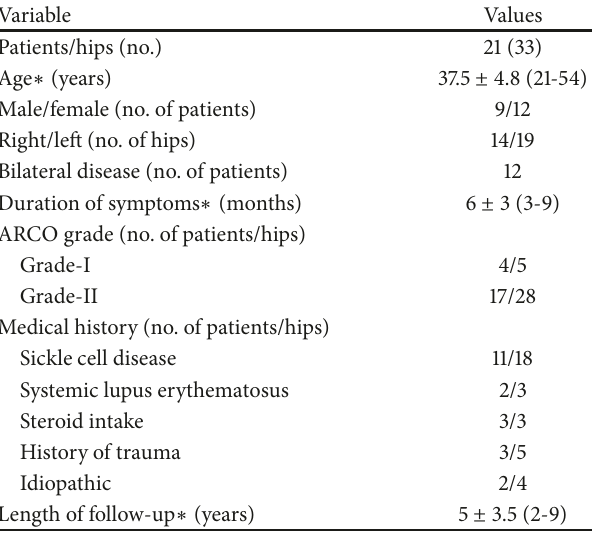
Table 1: Patient demographic